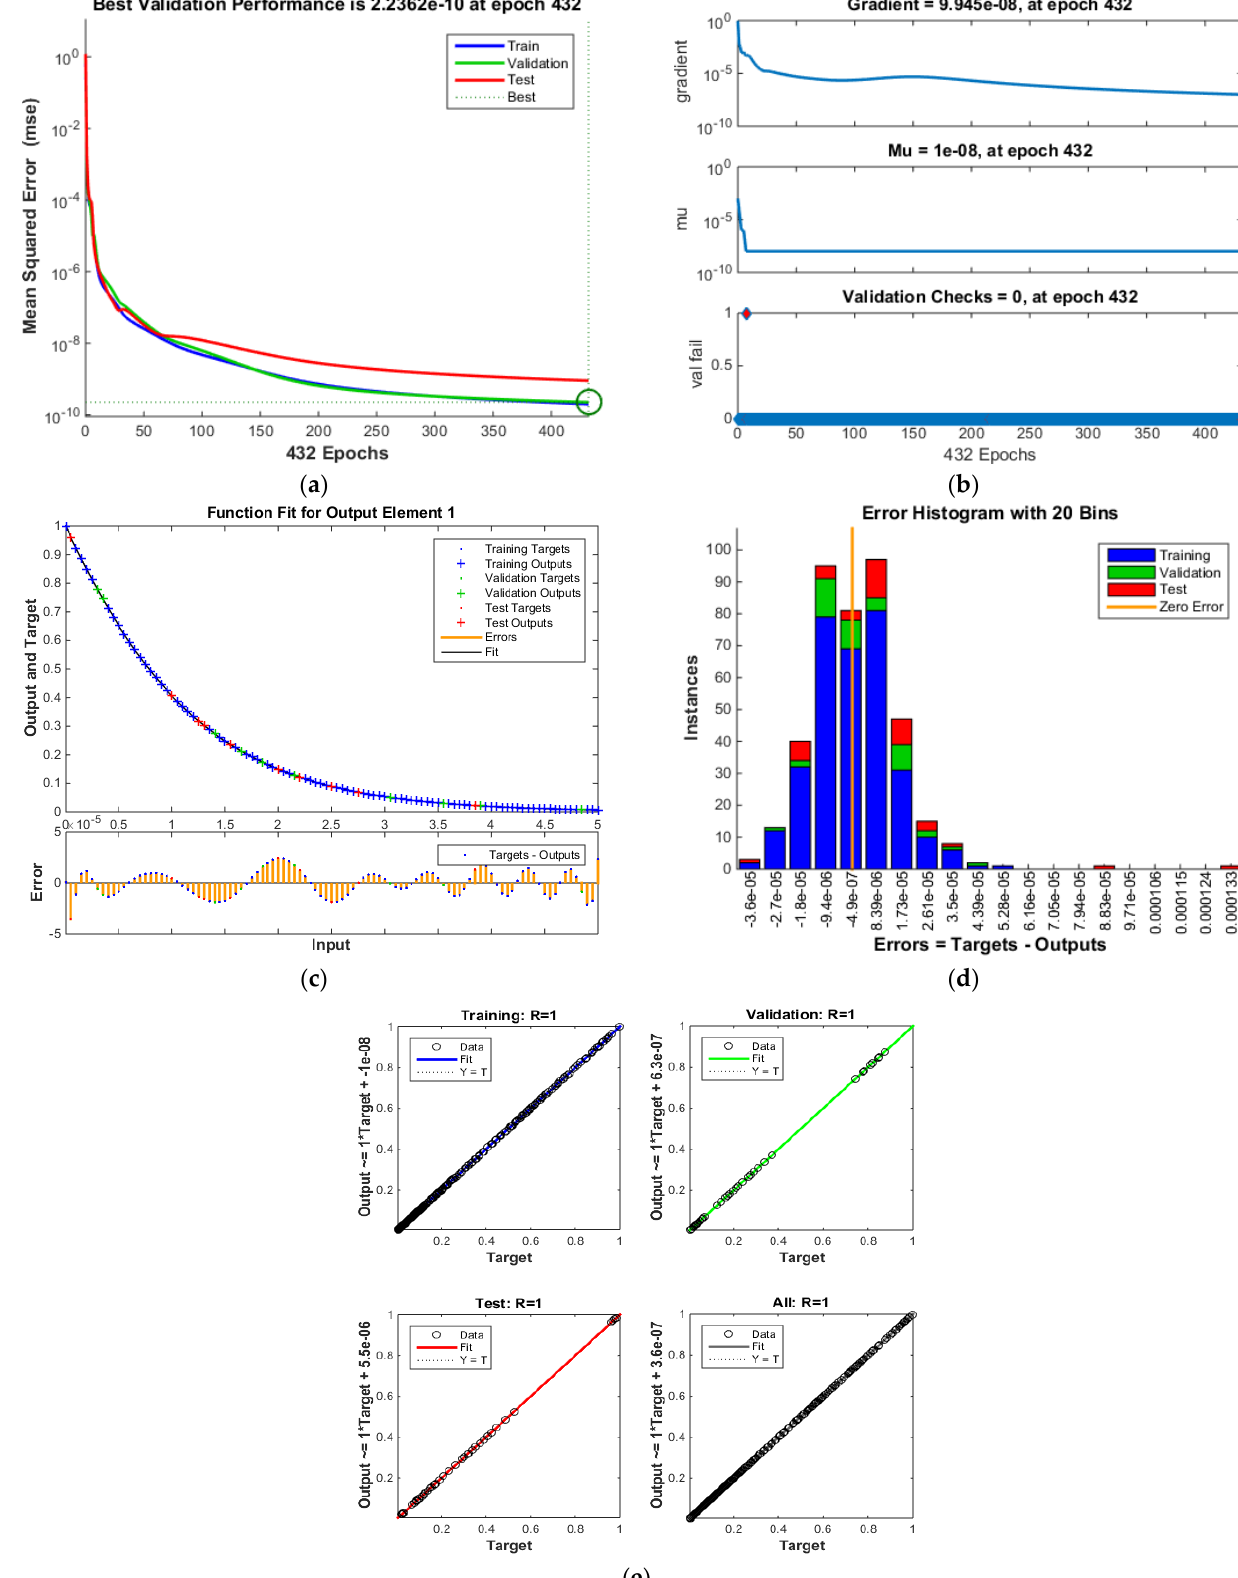
Figure 7. Graphic representation for designed LMT-ABPNN for solving cases of β for θ ( η ) of MHD-SGFM. ( a ) MSE Result, ( b ) Results of the transition state, ( c ) Fitness of the curve, ( d ) Histogram for error analysis, ( e ) Regression.